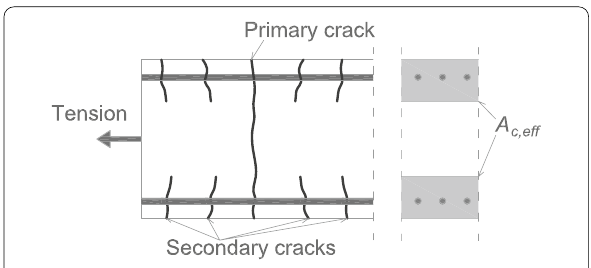
Fig. 2 Crack layout in the tie